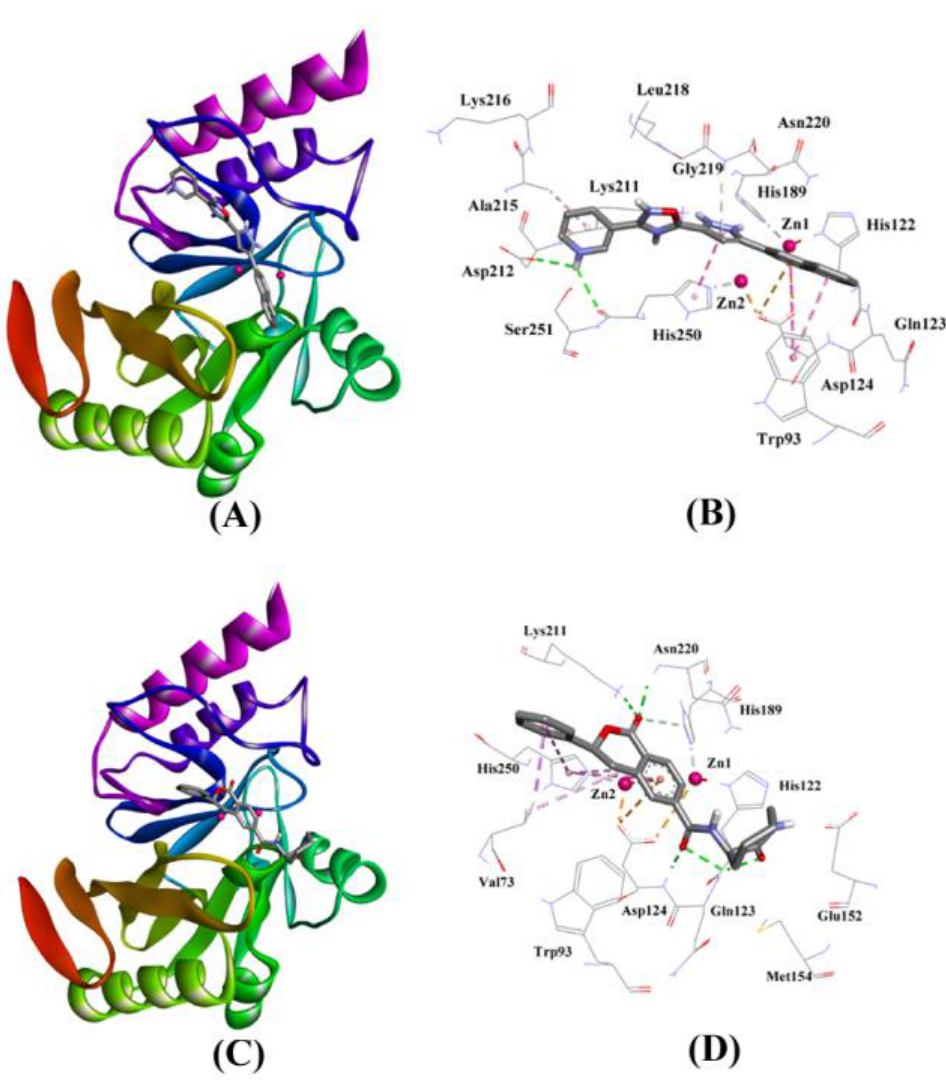
Figure 3. The molecular docking of ZINC7424911, and ZINC84525623 with of NDM-1. ( A ) The binding of ZINC7424911 at the active site cavity of NDM-1, ( B ) the molecular interactions between the amino acid residues of NDM-1 and ZINC7424911, ( C ) the binding of ZINC84525623 at the active site cavity of NDM-1, and ( D ) the molecular interactions between the amino acid residues of NDM-1 and ZINC84525623.